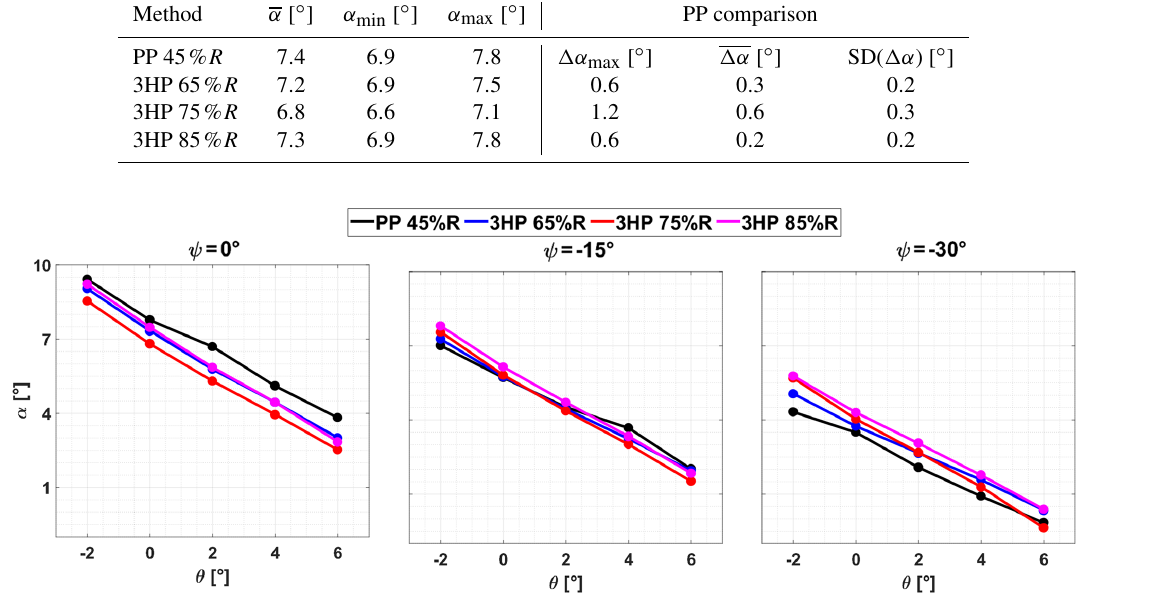
Figure 17. AoA estimations from pressure tap and three-hole-probe methods and variations with pitch angle. Three yaw cases ψ = 0, − 15 and − 30 ◦